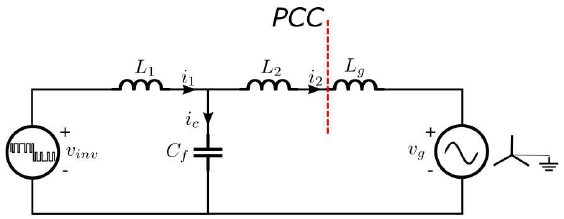
Figure 7. VSC dynamics under fast ROCOF connected to a simplified network.